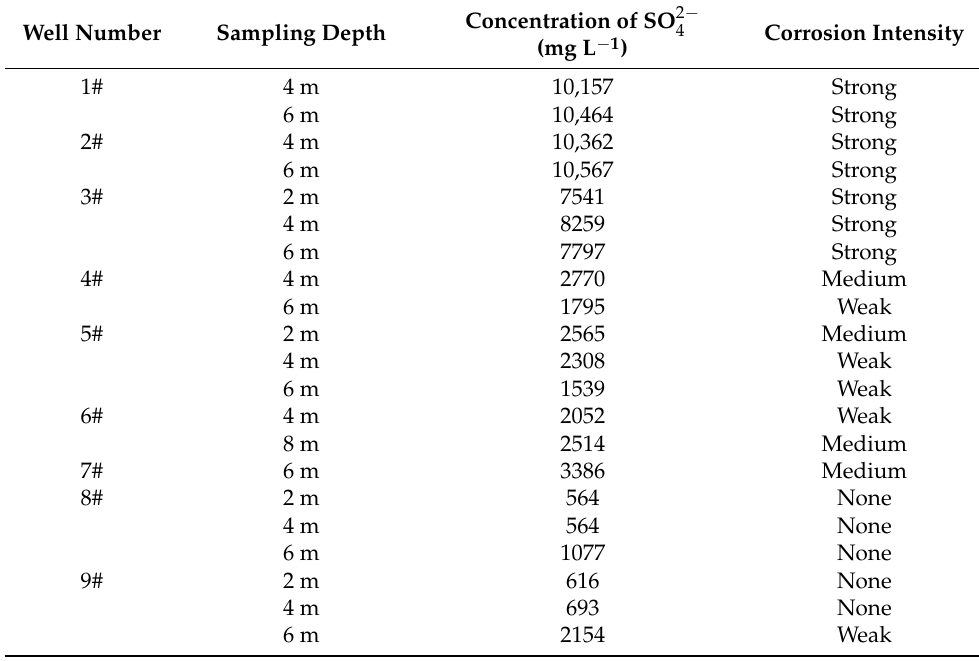
Table 2. Evaluation of sulfate corrosion of concrete in the groundwater.